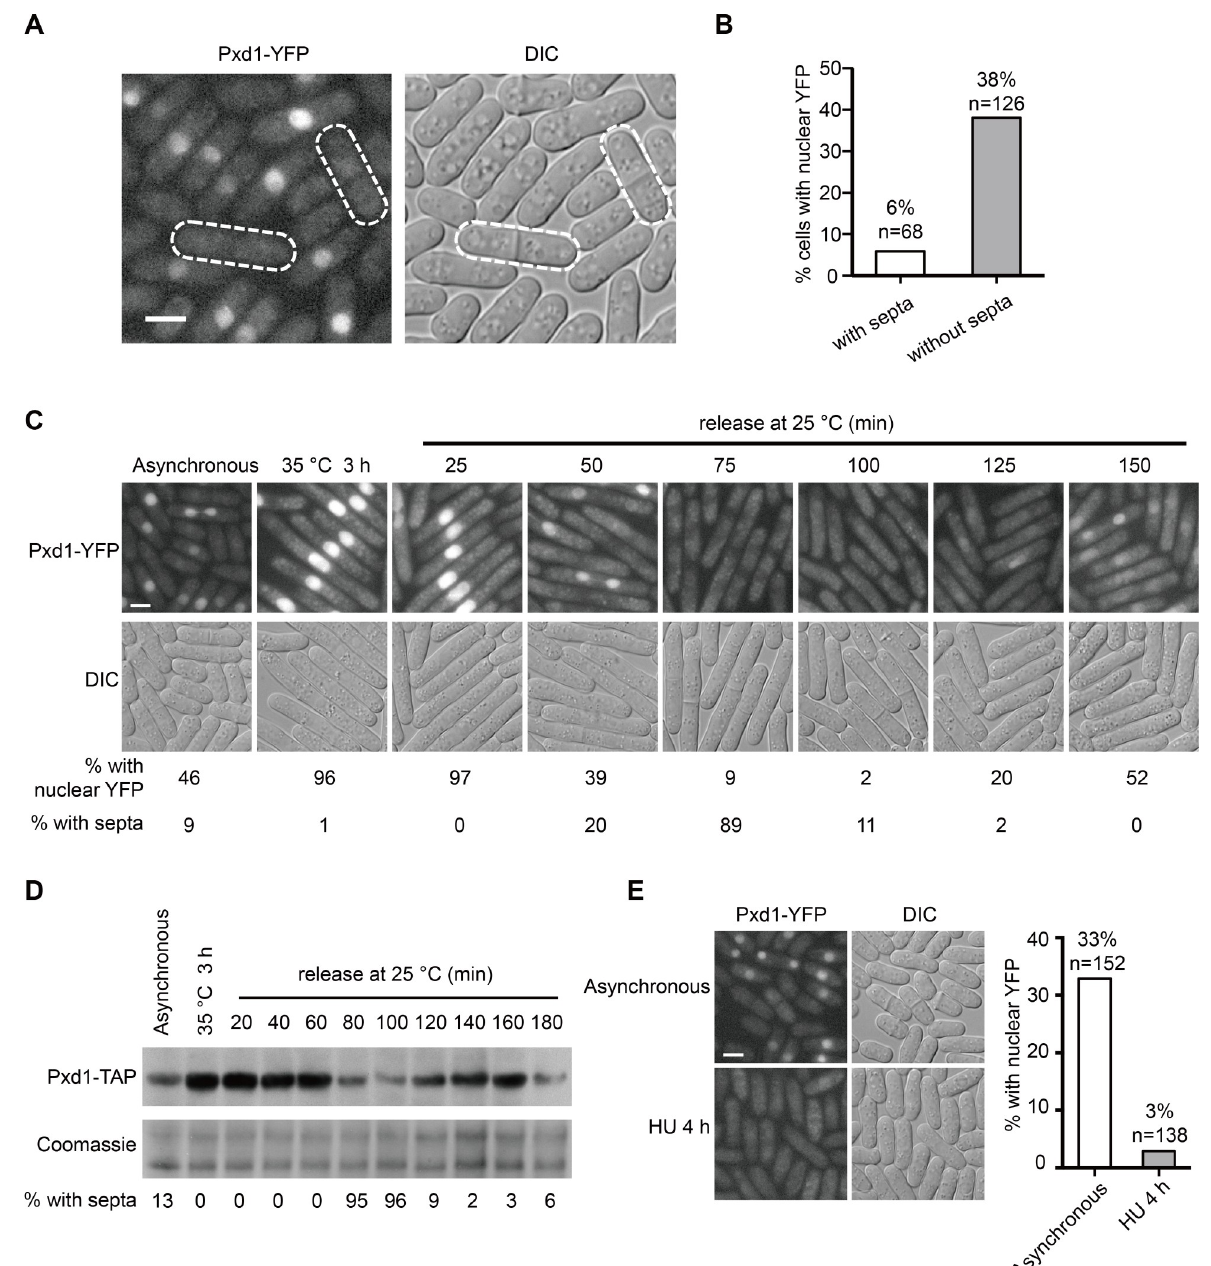
Fig 1. The protein level of Pxd1 is reduced in S phase. (A, B) Micrographs (A) and quantitation (B) showing that the fluorescence signal of Pxd1-YFP was more infrequently observed in septum-containing cells in an asynchronous culture. Endogenous Pxd1 was tagged with YFP. The fluorescence signal of Pxd1-YFP was observed by live cell imaging. The outlines of two cells with septa are marked by dashed lines. DIC, differential interference contrast. (C) The signal of Pxd1-YFP in cells synchronized by cdc25-22 arrest and release. Temperature-sensitive cdc25-22 mutant cells were arrested at G2 by incubating at 35˚C for 3 h, and then released back into the cell cycle by shifting to 25˚C. Cells was examined at indicated time points by live cell imaging. The percentage of cells with nuclear YFP signal and the percentage of cells with septa are shown. (D) The protein level of Pxd1-TAP in cells synchronized by cdc25-22 arrest and release. Endogenous Pxd1 was tagged with the TAP tag and was detected by immunoblotting using the peroxidase anti-peroxidase (PAP) reagent. Coomassie staining was used as loading control. (E) Micrographs (left) and quantitation (right) showing that HU treatment reduced the percentage of cells with visible fluorescence signal of Pxd1-YFP. Cells were treated with 12 mM HU for 4 h before examined by live cell imaging. Bars, 3 μ m. n, the number of cells used for quantitation.